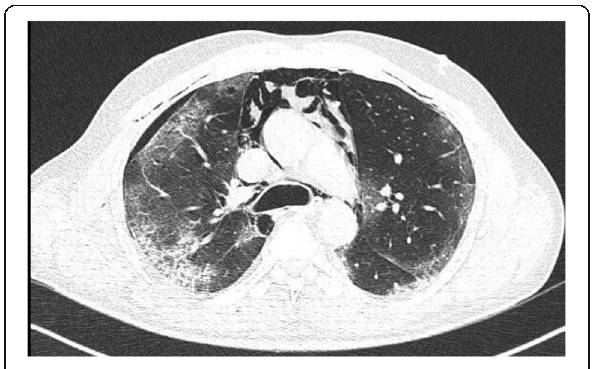
Fig. 9 CT scan thorax lung window showing small right sided pneumothorax, pneumomediastinum, surgical emphysema and lung parenchymal lesions typical of nCovid19 bronchopneumonia